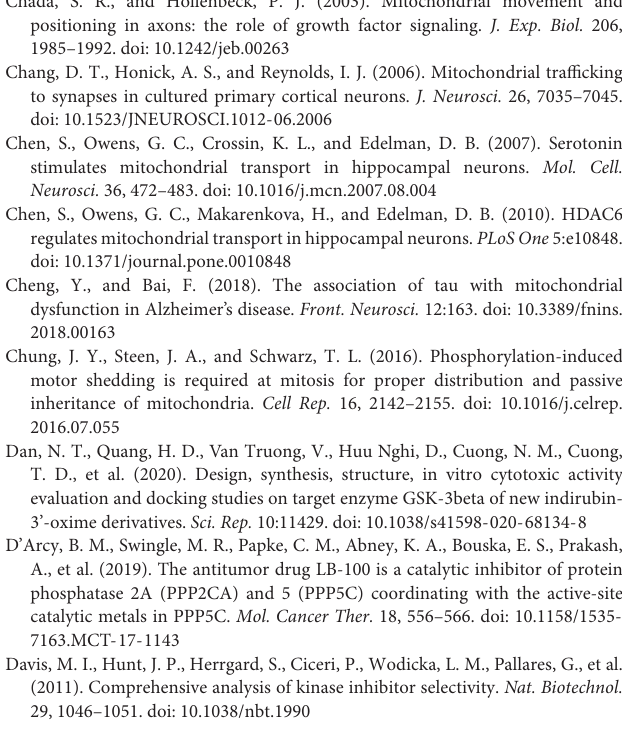
Supplementary Figure 1 | Comparison of the effects of DMSO and calcimycin in the screening platform. (A) Representative fields with tracking of mitochondria as analyzed by the PATH algorithm in neurons treated with 10 µ M DMSO or calcimycin. Stationary mitochondria are red and the tracks of moving mitochondria are blue. (B) From similar traces and using three concentrations of DMSO or 10 µ M calcimycin, the mean of the integrated distance traveled and the KS2 Z -score are shown. Tukey’s box plot was used for all data, and the error bars represent SD. Supplementary Figure 2 | Mitochondrial motility in the presence of GSK-3 β or CDKs inhibitors. The mean of integrated distance at three concentrations of six GSK-3 β inhibitors (A) and six CDKs inhibitors (B) . Dotted lines represent the average value of mitochondria motility in DMSO treated neurons. More extensive dose-response curves over a broader concentrations range for dabrafenib (C) , rebastinib (D) , SU9516 (E) , tideglusib (F) , and TWS 119 (G) using at least six different concentrations. Tukey’s box plot was used for all data, and the error bars represent SD. All experiments were done in two independent cultures with four wells were imaged per condition, each containing dozens of axons. Supplementary Table 1 | Compounds screened. List of the 240 compounds and their sources whose screen results are summarized in Figure 1D . For each compound, the Z -scores of the median percent motile are given for each of two replicates. The values for the DMSO controls included on each plate are also